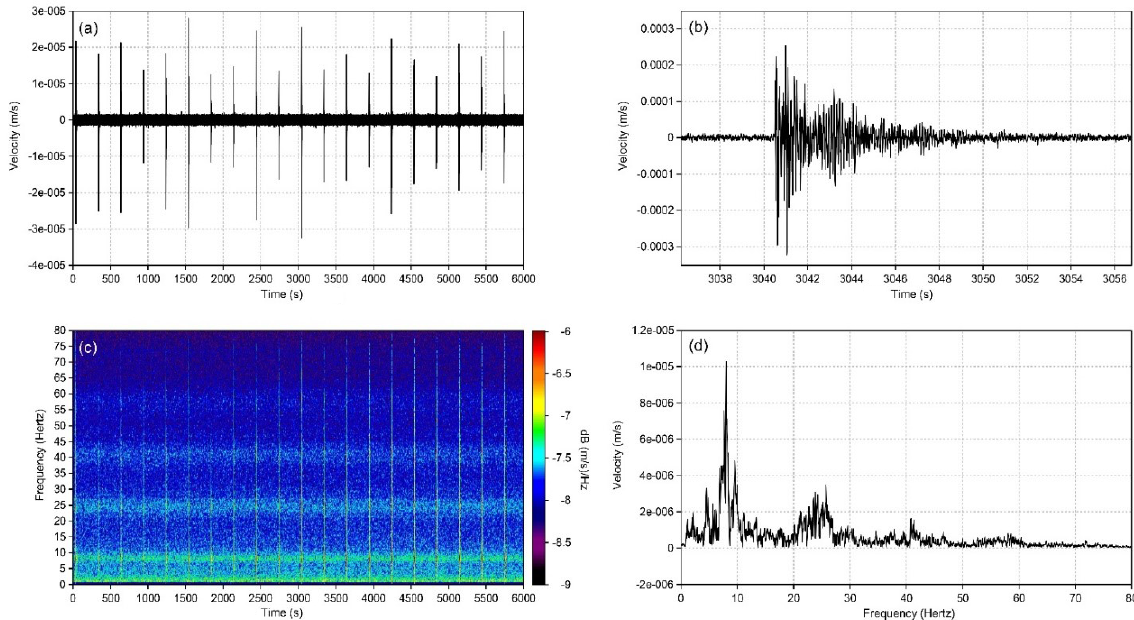
Figure 10. Example of micro-seismicity record by the seismic station installed at Santa Barbara: (a) time signal relative to some minutes of the vertical component (velocity) record and (b) zoom on a single waveform with relative spectrogram (c) and amplitude spectrum (d) . The spectrogram allows us to highlight the presence in the ambient noise of a continuous energy band in the frequency range 5–10Hz and some possible overtones. The same frequencies can be identified in the amplitude spectra of the micro-events, suggesting a possible link to local resonance